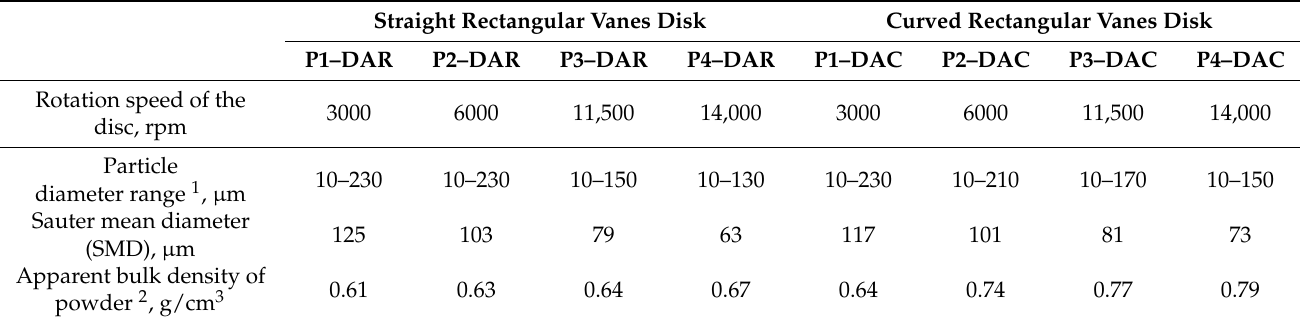
Table 2. Physical properties of spray-dried 25SA microspheres calcined at 550 °C.